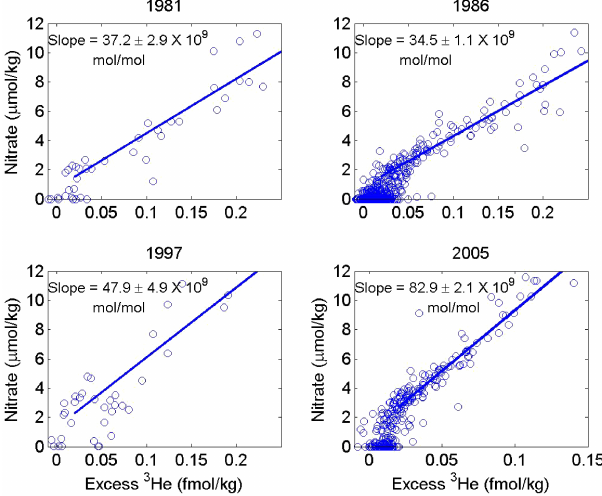
Figure 3. The observed relationship between excess (tritiugenic) 3 He and dissolved inorganic nitrate near Bermuda at four points in time. The 1986 and 2005 relations are based on approximately 3-year time series occupations near Bermuda (the former at Hydro- station S and the latter at BATS). The 1981 and 1997 data sets are from cruise stations within ∼ 500km of the site. Only samples with potential density anomalies less than 26.8kgm − 3 are plotted and used. Note the “waterfall” effect at low 3 He and nitrate concentra- tions in the euphotic zone, where the two tracers become uncoupled due to differing boundary conditions. The straight lines, from which the slopes are obtained, are type II linear regressions of points with nitrate concentrations in excess of 2µmolkg − 1 . The lower bound nitrate limit was chosen to avoid the tracer-decoupled